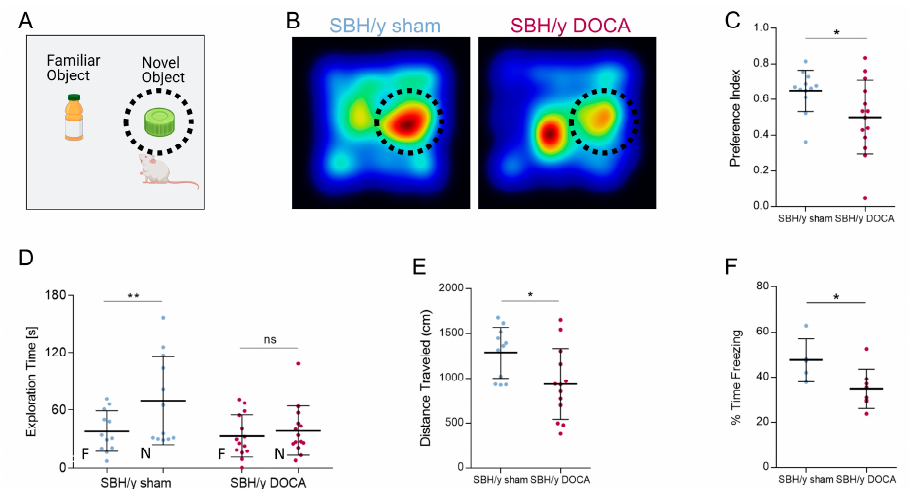
Figure 6. Cognitive deficits in SBH/y-DOCA rats. Novel object recognition (NOR) test schematic illustration ( A ) and heatmaps of averaged cumulative time spent next to the novel object (marked by dashed circle) of SBH/y sham ( n = 12) and SBH/y-DOCA ( n = 14) rats during the NOR test trial, 50 days following DOCA treatment ( B ). Preference index ( C ) and exploration time ( D ) of SBH/y sham and SBH/y-DOCA during the NOR test trial. Distance traveled during the NOR training trial (E) . Freezing time of SBH/y sham ( n = 5) and SBH/y-DOCA ( n = 8) rats 41 days following DOCA treatment during contextual fear conditioning test ( F ). Data are presented as mean ± SD. * p < 0.05, ** p < 0.01, two-tailed t